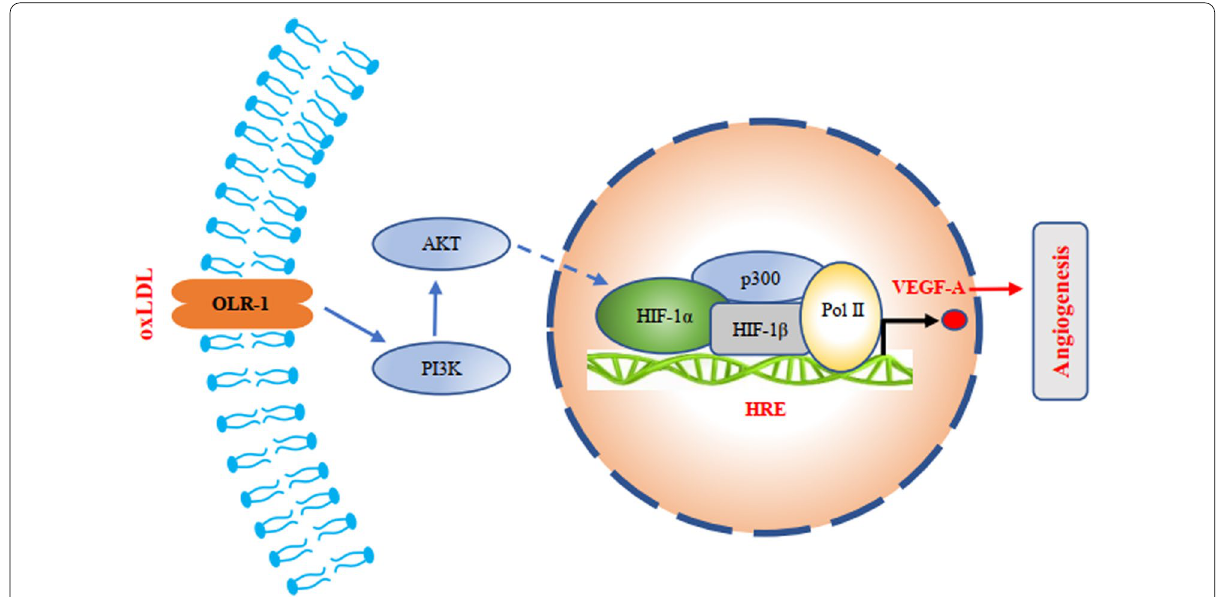
Fig. 7 Schematic diagram of oxLDL upregulating VEGF-A